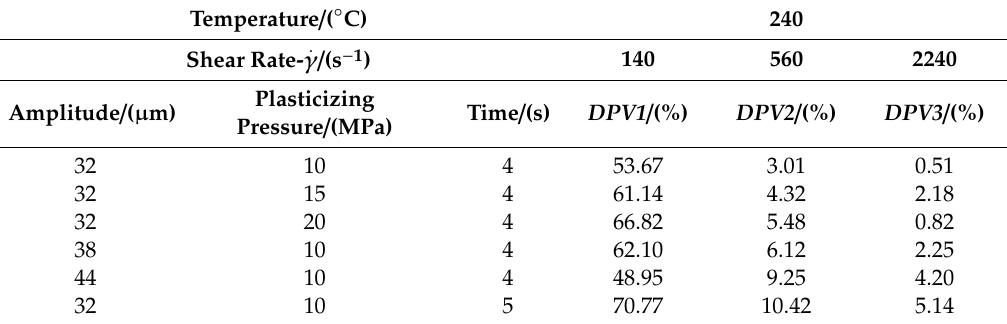
Table 6. Variables involved in MLRA for mode 1 and their values.